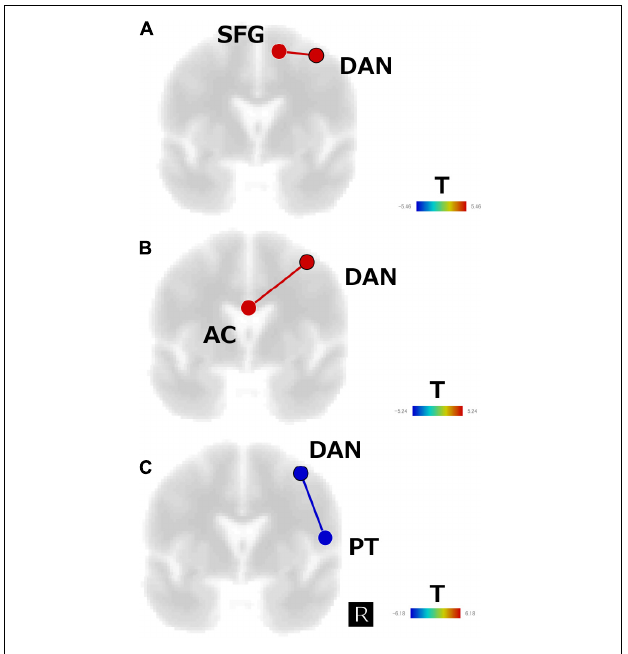
FIGURE 4 | Subtraction map of (A) responders minus healthy subjects, (B) non-responders minus healthy subjects, and (C) responders minus non-responders for the regions of interest analysis of the first scan data. The connectivity map is displayed in the coronal view and overlaid on a template image. The color bar indicates the t -value. SFG, superior frontal gyrus; AC, anterior cingulate; DAN, dorsal attention network; PT, planum temporale.